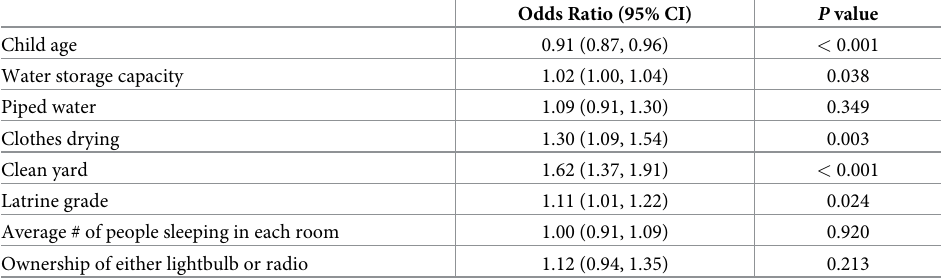
Table 3. Multivariate logistic regression of children’s facial cleanliness with generalized estimating equation to account for clustering at the household